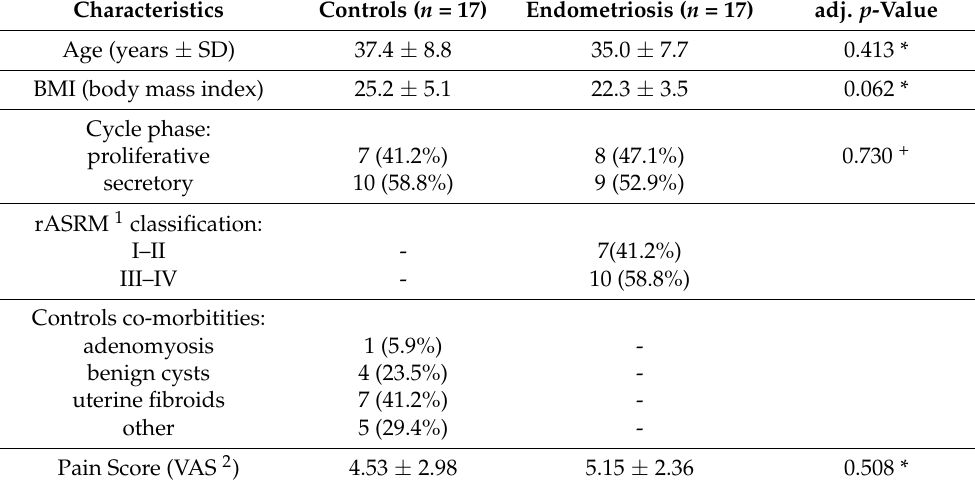
Table 2. Patient